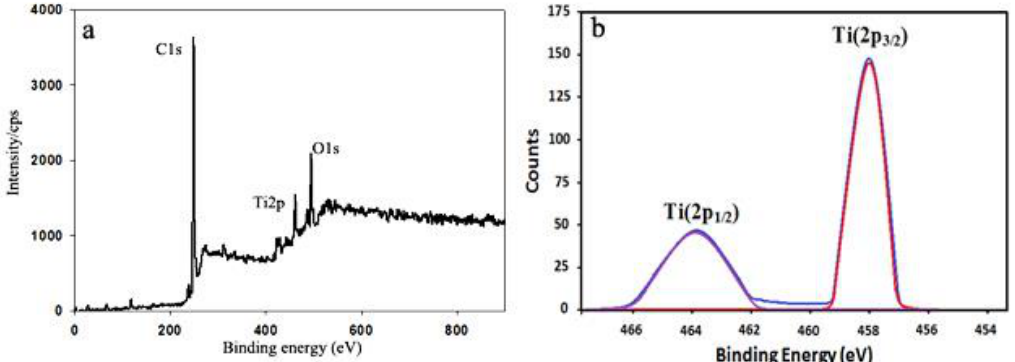
Figure 6. X-ray photoelectron spectroscopy (XPS) spectra of PPM5 / TiO 2 ( a ), Resolved XPS spectra for Ti2p ( b ) .